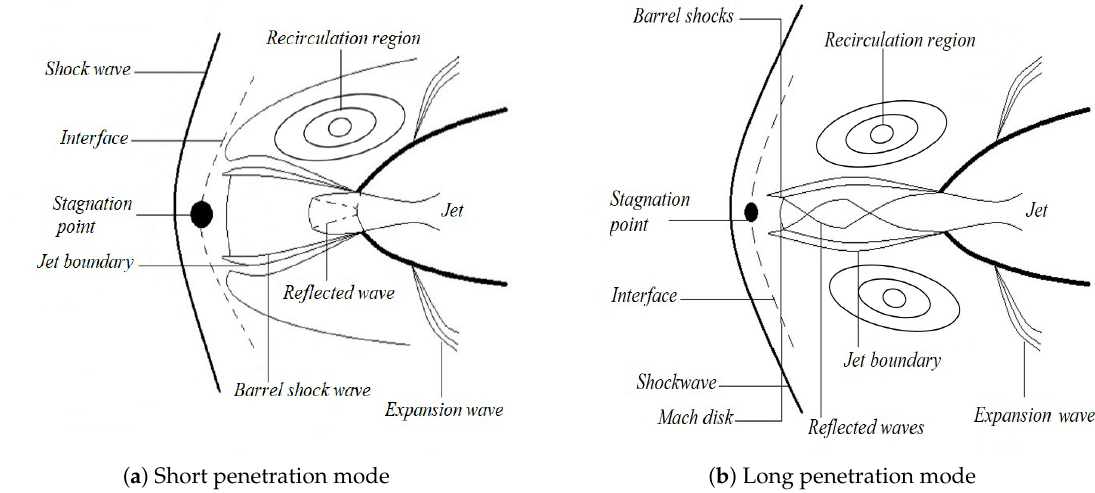
Figure 1. Schematic configuration of opposing jet with two distinct